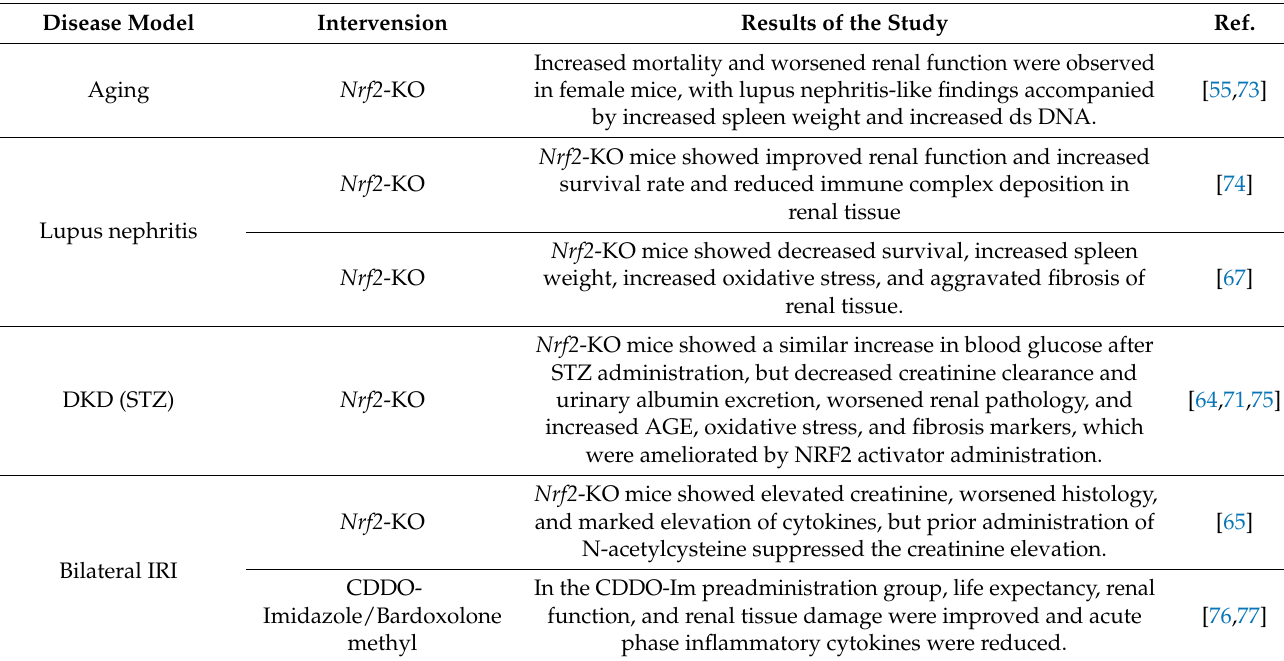
Table 1. Function of Nrf2 in the kidney. The following is a list of major studies that have demonstrated the function of Nrf2 in the kidney using animal models. (KO, knockout; CKO, conditional knockout; KD, knockdown; ds-DNA, double- stranded DNA; AGE, advanced glycation end product; CDDO, 2-cyano-3,12-dioxolane-1,9-dien-28-oic acid; BUN, blood urea nitrogen; AST, aspartate transaminase; IRI, ischemia–reperfusion-injury). Disease